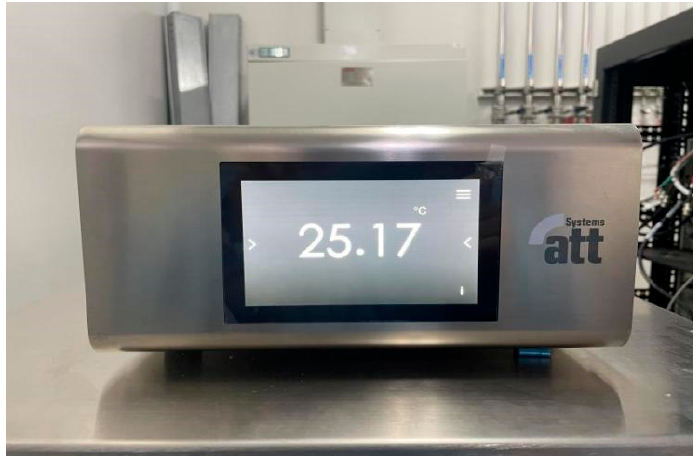
Figure 4. Temperature test chamber.